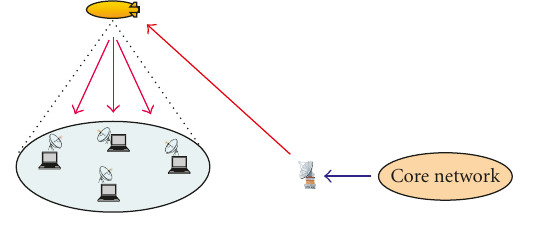
Figure 3: Stand-alone HAP.